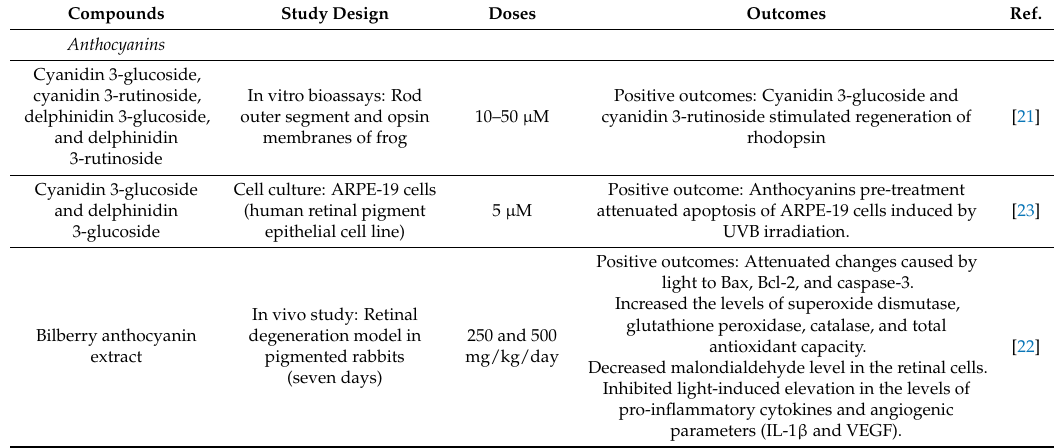
Table 1. Protective effects of anthocyanins and carotenoids against age-related macular degeneration and eye-related